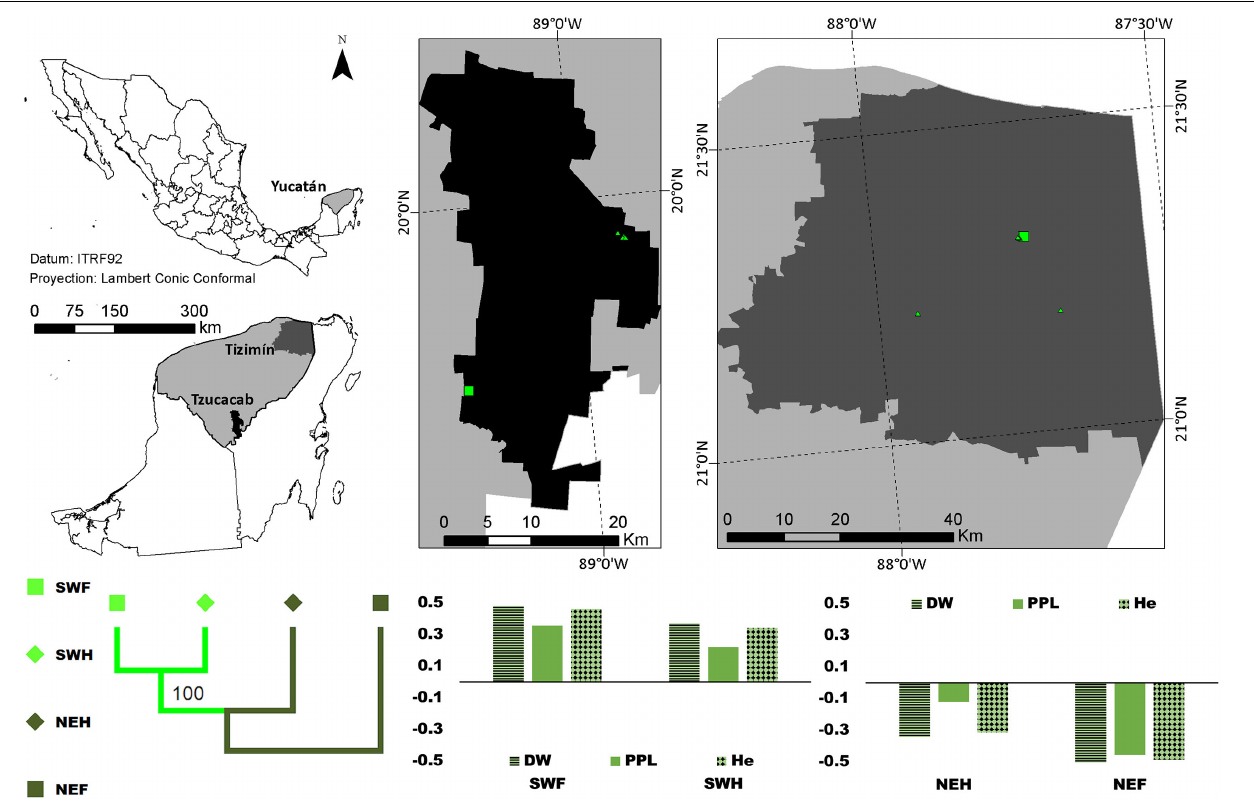
FIGURE 1 | Distribution of forest (square) and homegarden (triangle) individuals of Brosimum alicastrum in two regions of Yucatán, México. The graphic depicted the standardized mean values for PPL-horizontal lines, DW -solid color, and He-diamond pattern [ (cid:0) x i − x (cid:1) / x where x i is the mean value per region/population type and x the overall mean value]; negative and positive values indicate values below and above the overall mean. The dendrogram for the paired F ST between each combination of the region (northeast -NE- dark green, and southwest-SW- light green) and population type (forests -squares- and homegardens -diamonds-) suggests almost no differentiation between southwestern forest and homegarden populations with a 100% bootstrap support, and this group and the homegarden of northeastern